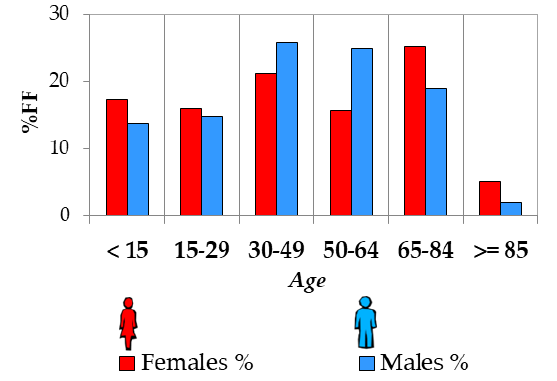
Figure 8. Proportion of male and female fatalities per classes of age for total area (TOT-A).